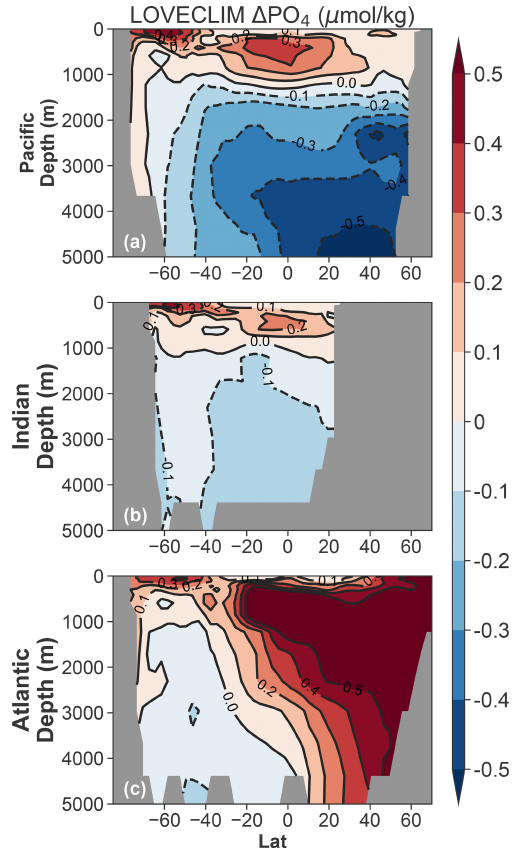
Figure 8. Ocean basin zonal mean PO 4 anomalies (15ka minus 17.2ka) as simulated in